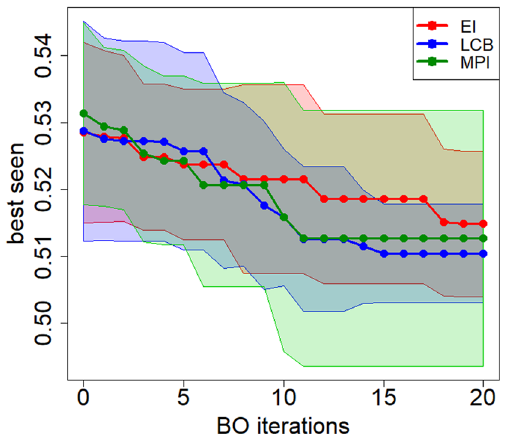
Figure 3. Comparison among GP-based BO processes using three different acquisition functions.